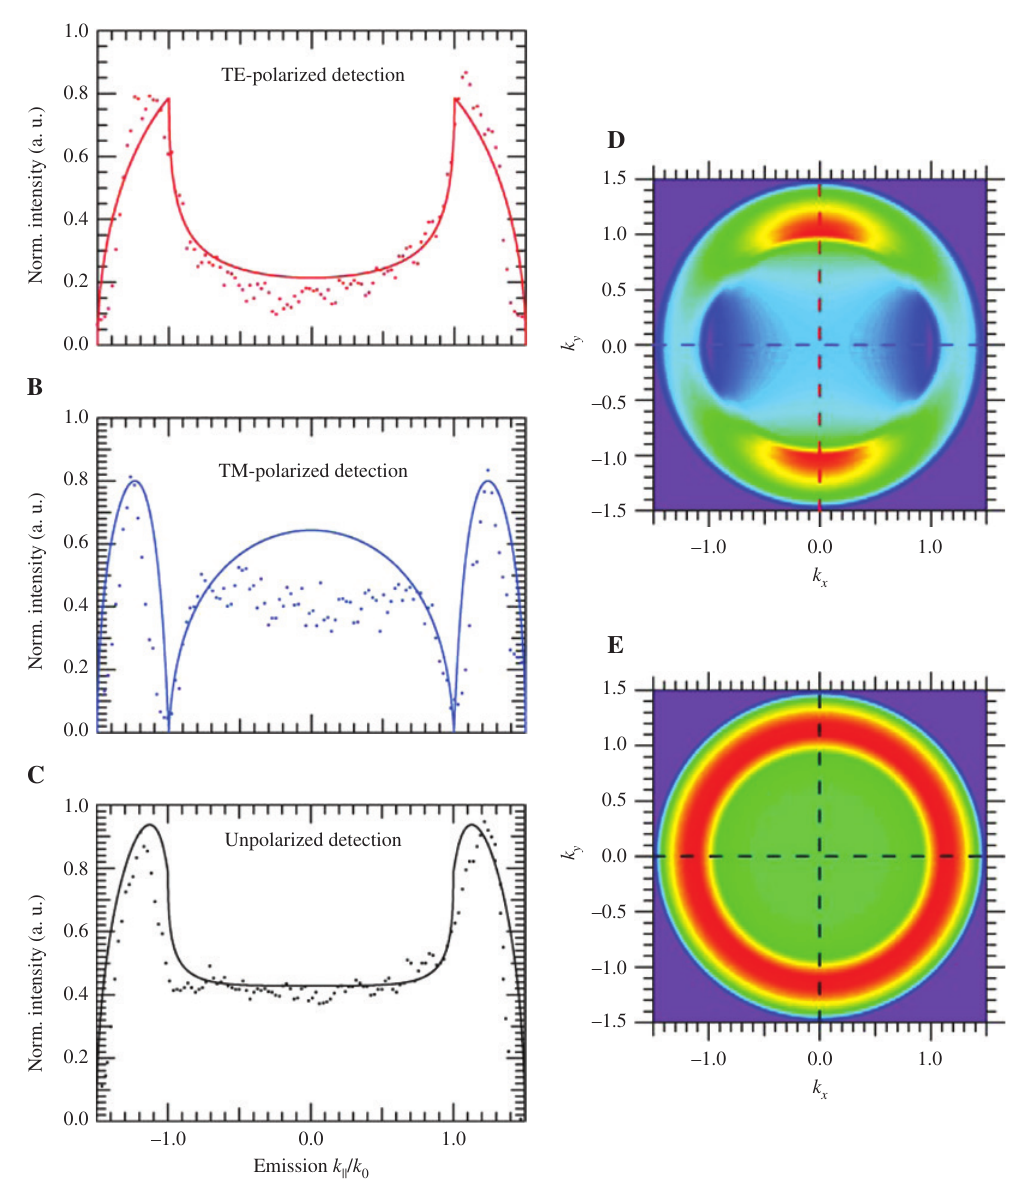
Figure 2: Comparison between experimental (extracted from Ref. [47]) and calculated BFP cross-sections for the Raman G mode of graphene for TE-polarized (A), TM-polarized (B), and unpolarized (C) detection, respectively. Calculated BFP images of the Raman G mode of graphene for polarized (D) and unpolarized (E)